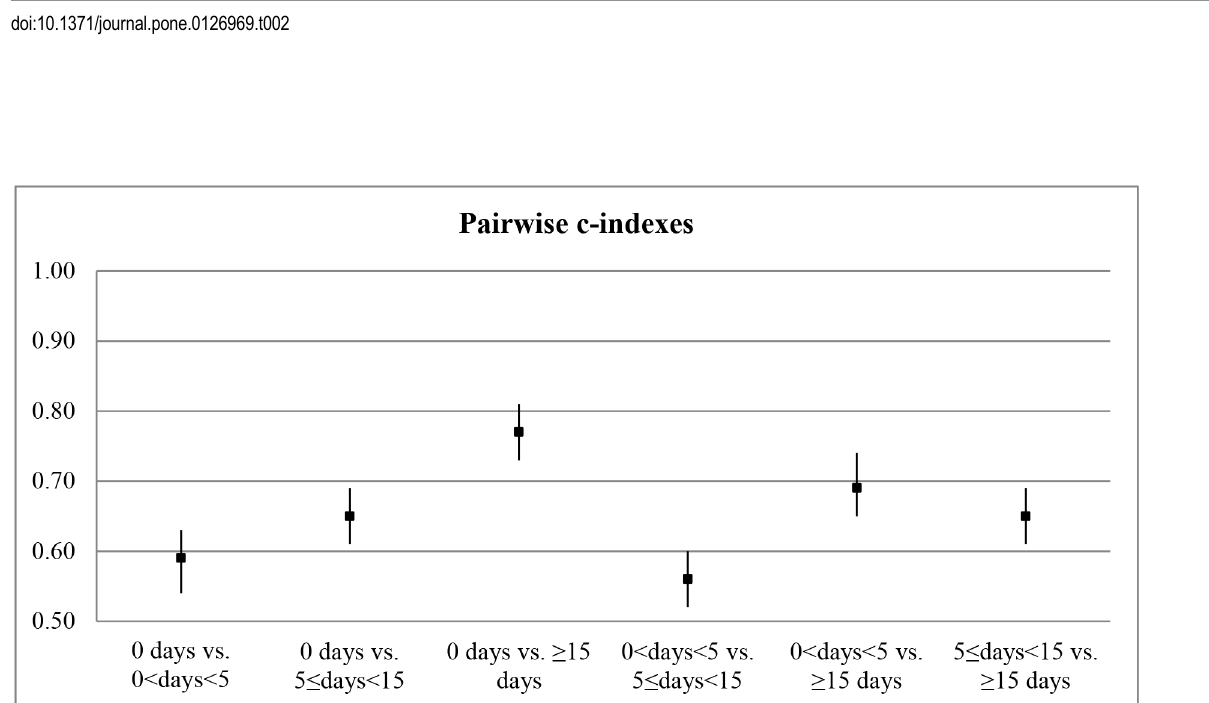
Fig 1. Pairwise AUCs: ability of the work ability index (WAI) to discriminate between categories of sickness absence. AUC: Area under the